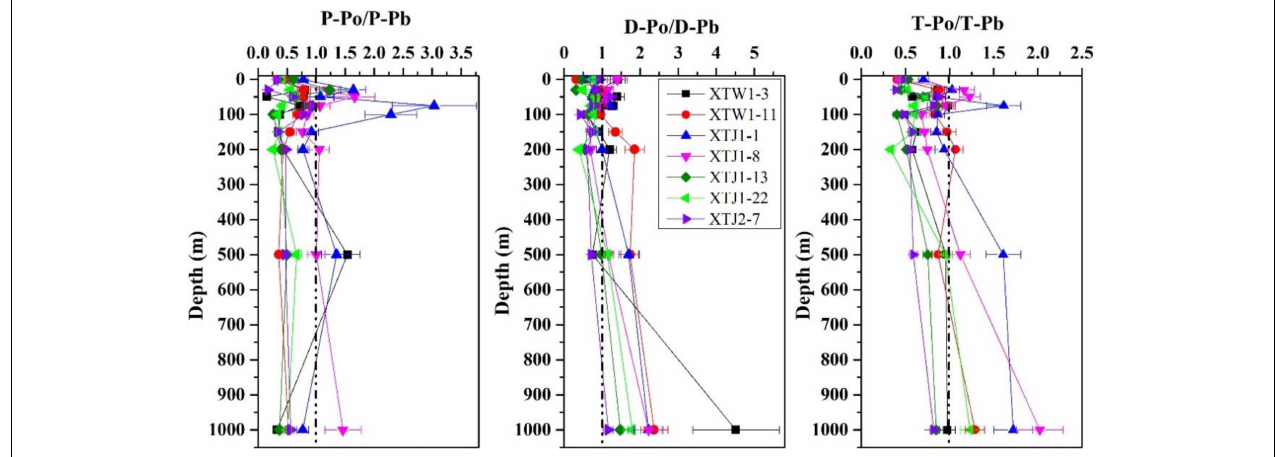
FIGURE 7 | Profiles of the activity ratios of 210 Po/ 210 Pb in the particulate, dissolved and total fractions in